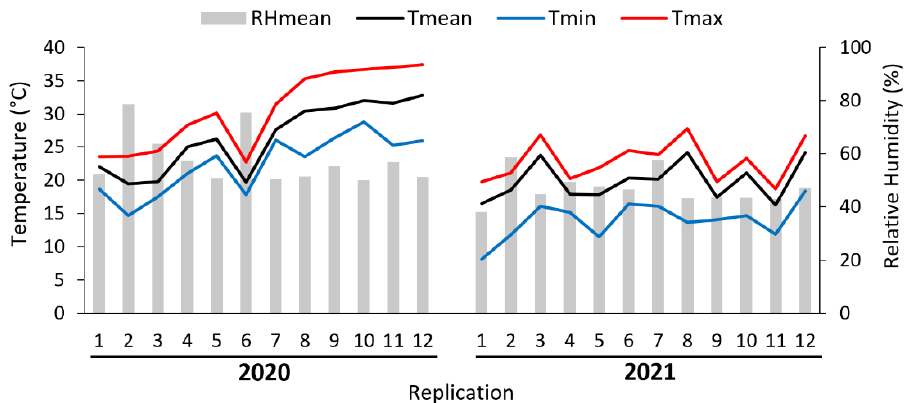
Figure 2. Mean (Tmean), minimum (Tmin), maximum (Tmax) temperatures and mean relative humidity (RHmean) during semi-field cage trials.